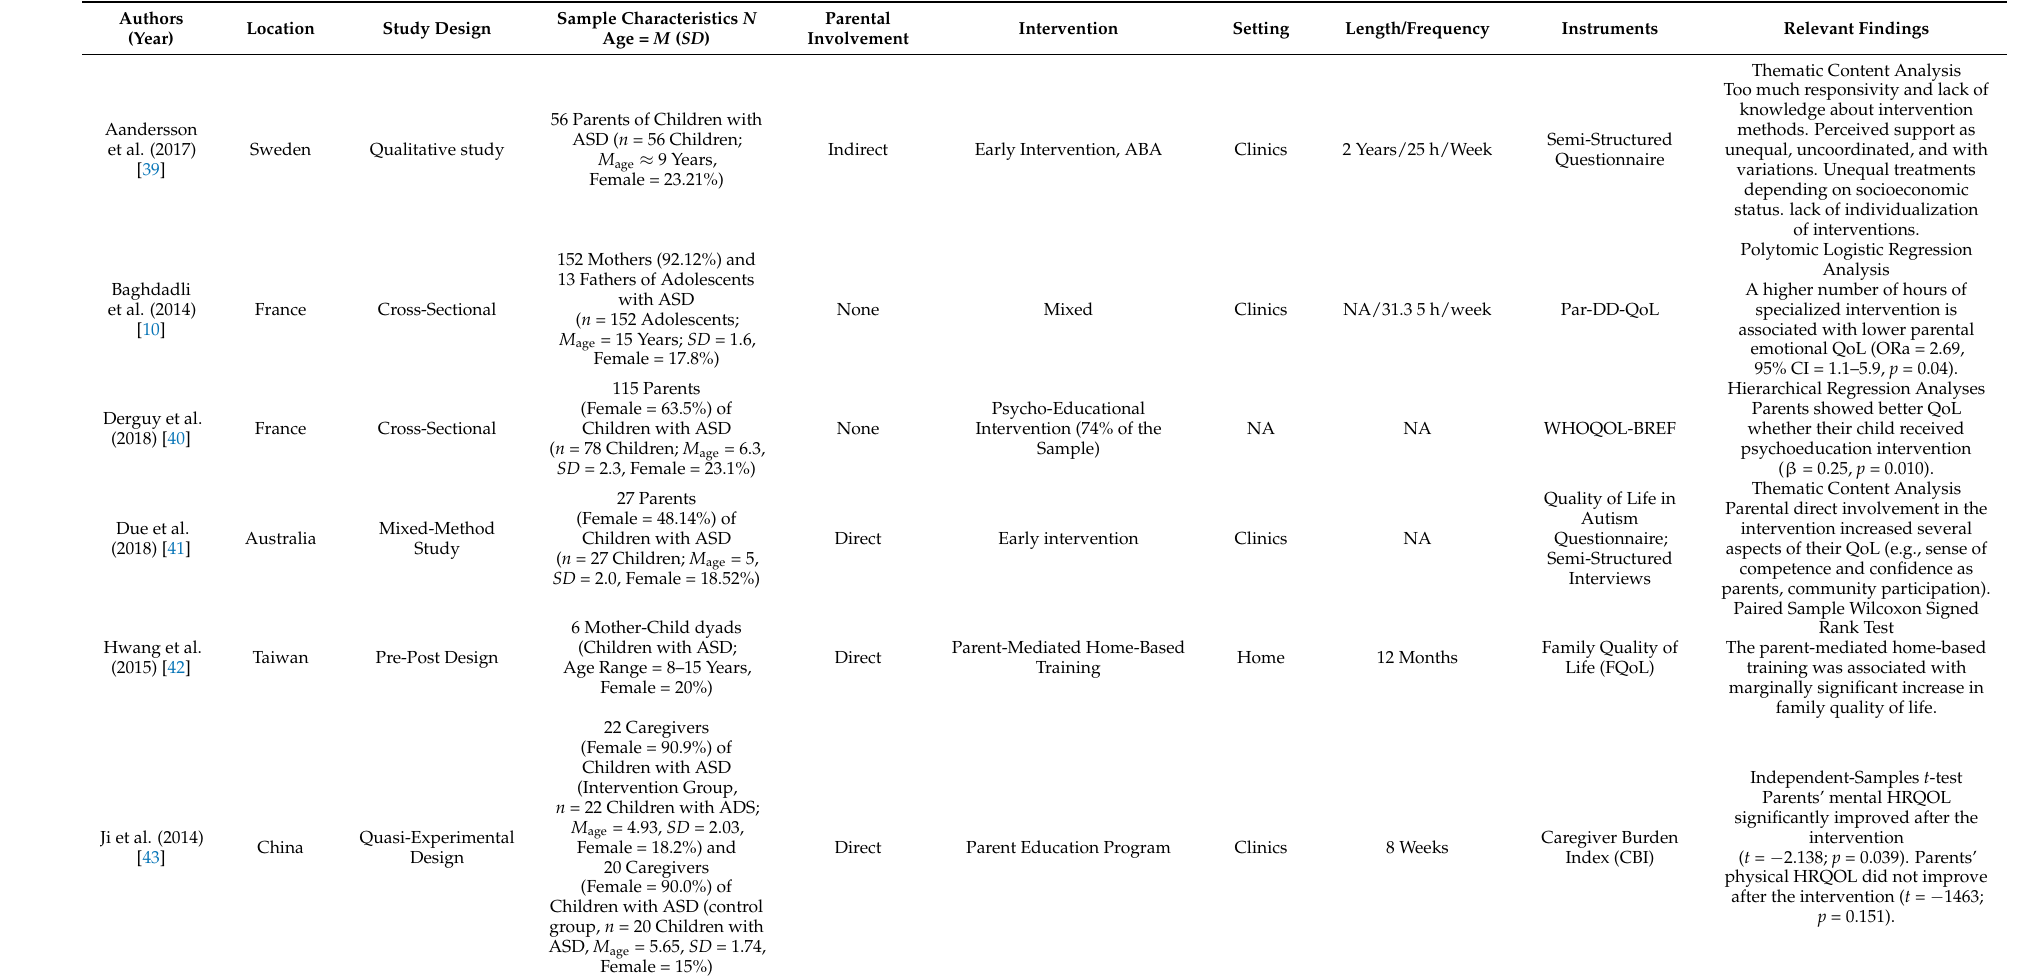
Table 1. Characteristics of the reviewed studies ( n =